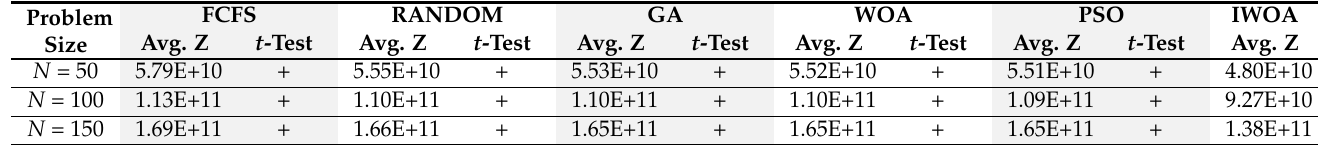
Table 6. Results of t -test for different approaches at different problem